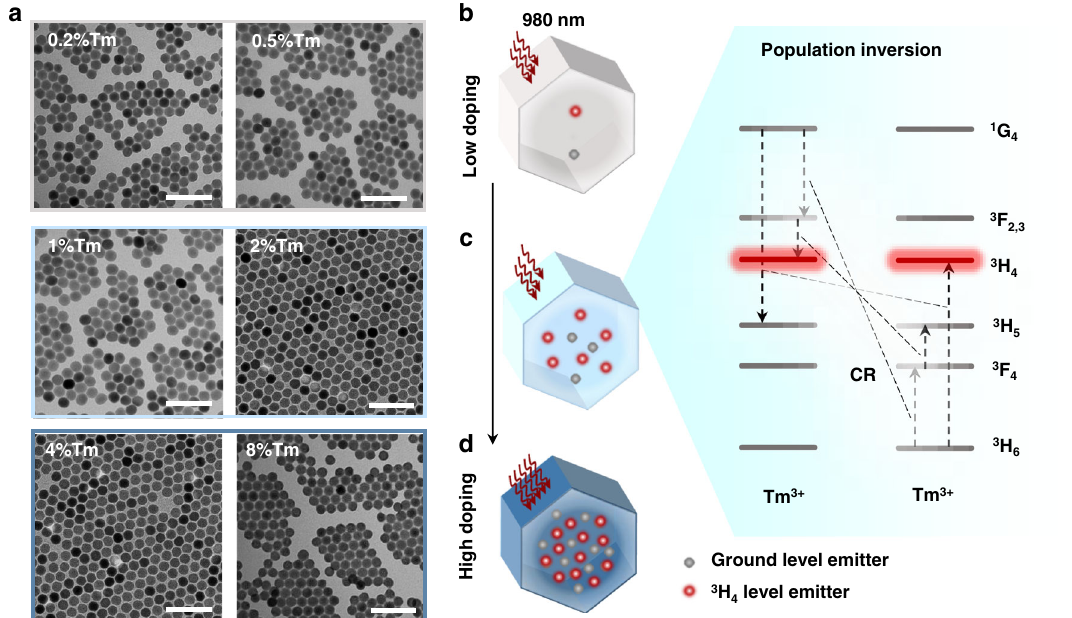
Fig. 1 The role of CR in promoting the establishment of population inversion for low threshold lasing. a TEM images of a series of monodispersed 24 nm UCNPs. Scale bar 100 nm. b – d Schematic illustration of the simpli fi ed energy level diagram and the role of doping concentration of Tm 3 + in establishing the CR enabled population inversion of 3 H 4 level, compared to the ground level.